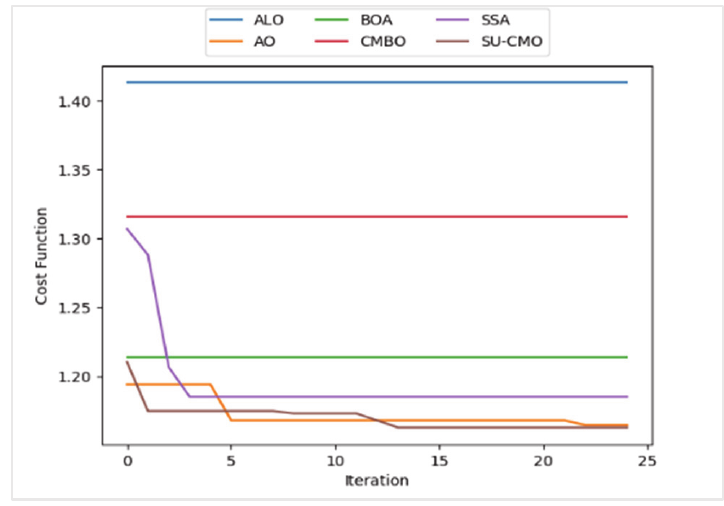
Figure 7. Convergence Analysis